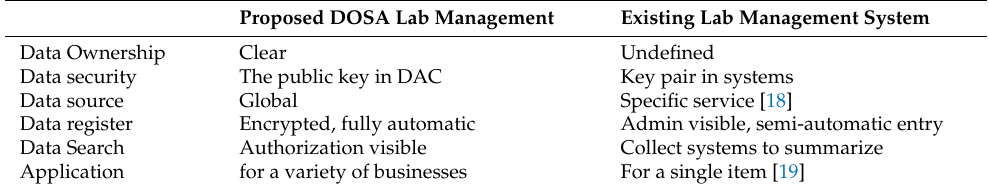
Table 1. Comparison of the proposed architecture and existing lab management.